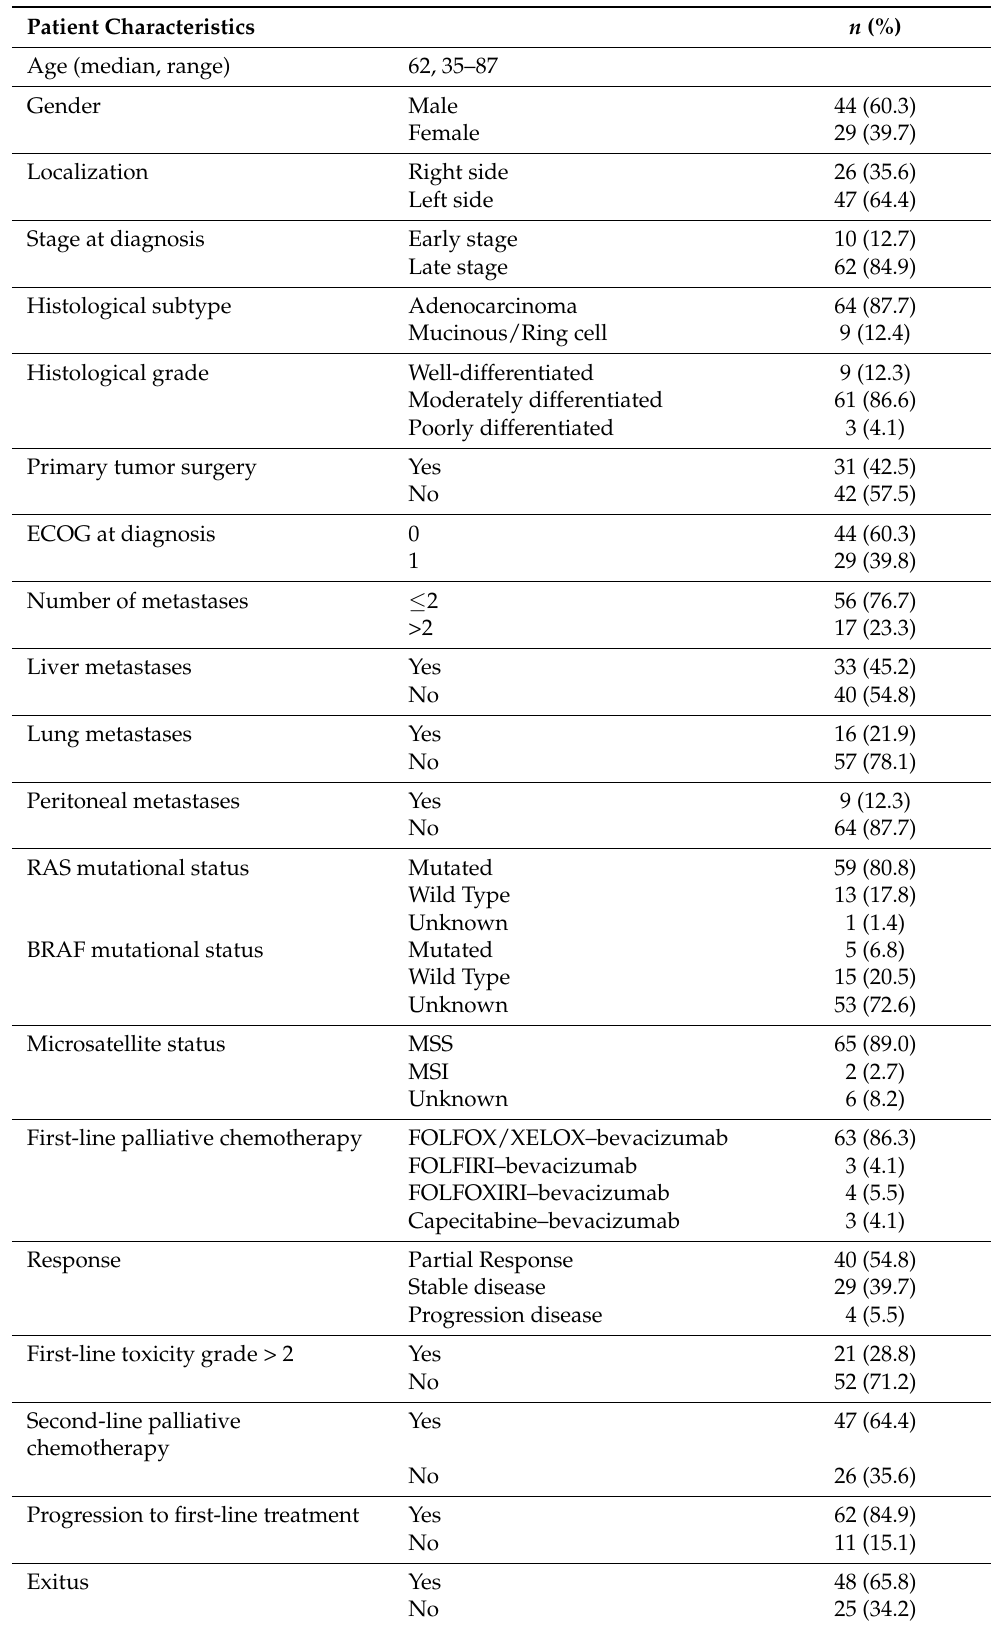
Table 1. Clinical pathological data of